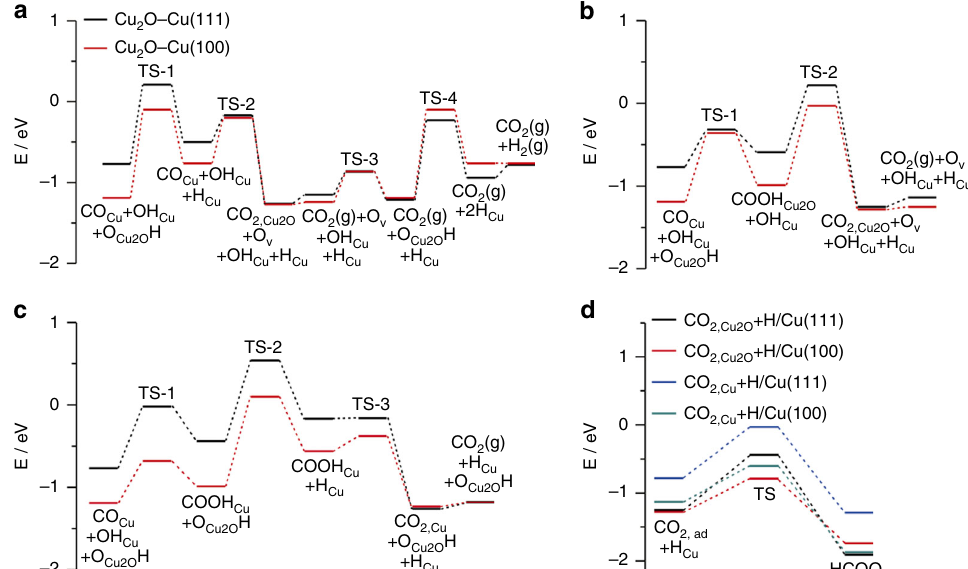
Fig. 6 Calculated energy diagram of WGS reaction. a The reaction for CO at the Cu site (CO Cu ) and O of Cu 2 O at Cu 2 O – Cu(111) ( black line ) and Cu 2 O – Cu (100) ( red line ) interfaces. O v represents an oxygen vacancy in Cu 2 O. b The reaction for CO Cu and O Cu2O H at the Cu 2 O – Cu(111) ( black line ) and Cu 2 O – Cu (100) ( red line ) interfaces. c The reaction for CO Cu and OH Cu at the Cu 2 O – Cu(111) ( black line ) and Cu 2 O – Cu(100) ( red line ) interfaces; the subsequent elementary reactions following the formation of CO 2 (g)+ O v + OH Cu + H Cu are identical to those in a . d The elementary reaction between CO 2,ad and H Cu to form HCOO ad at the Cu 2 O – Cu(111) and Cu 2 O – Cu(100)